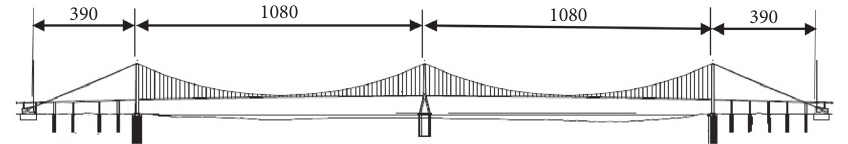
Figure 1: Overall layout of the Taizhou Yangtze river bridge (unit: M).